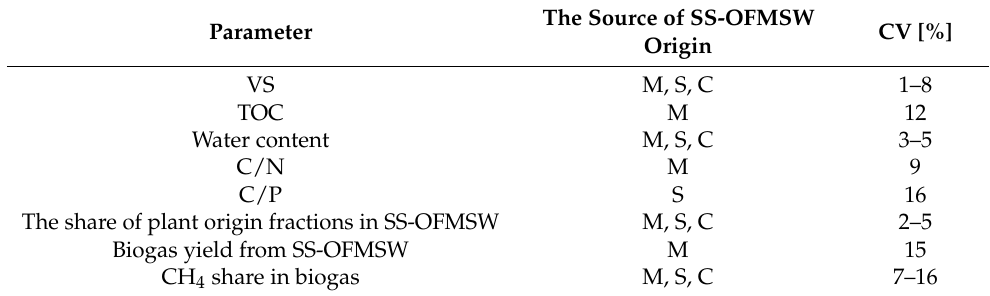
Table 5. The parameters of the tested food waste from Warsaw, which present a CV ≤ 16%. Parameter